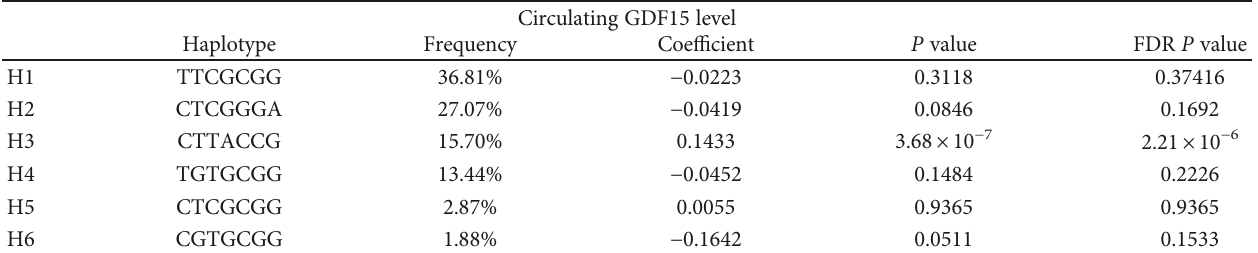
Table 3: Association of growth di ff erentiation factor 15 ( GDF15 ) locus haplotypes with circulating GDF15 level in subjects from the healthy